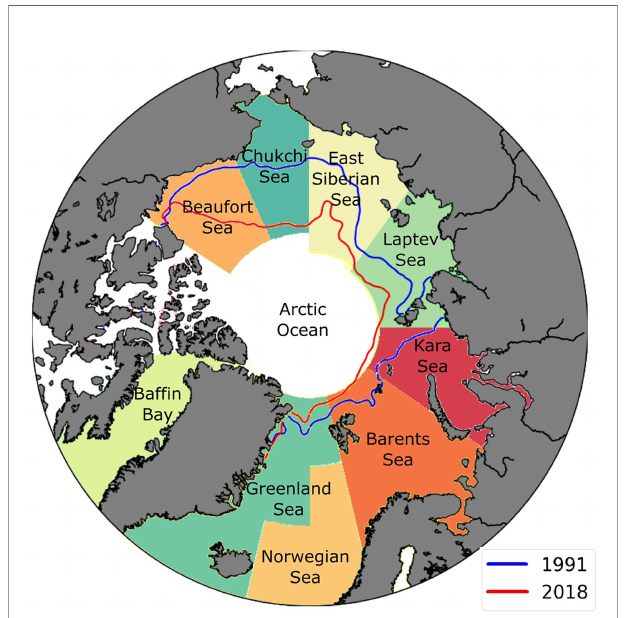
FIGURE 1 | Regions of the Arctic Ocean used in this study with lines showing sea ice extent in September of 1991 (blue) and 2018 (red). Sea ice concentration dataset from ERA5